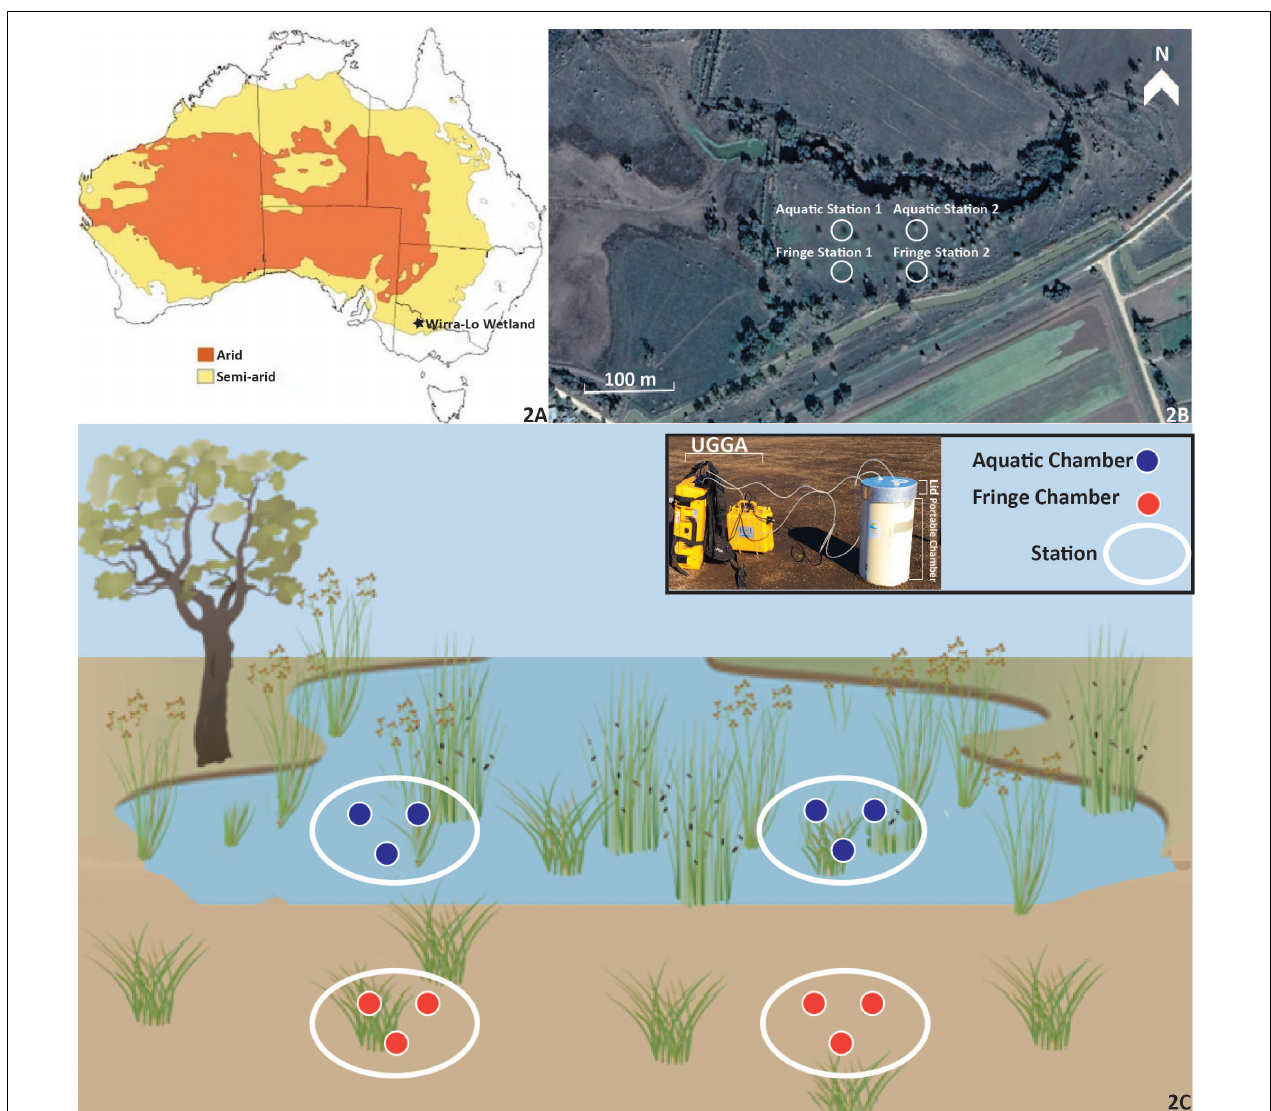
FIGURE 2 | The Wirra-lo wetland complex located in the semi-arid climate of North Central Victoria, Australia ( − 35.503353, 143.873565). Arid and semi-arid regions of Australia (A) are low in annual precipitation (100–500 mm year − 1 ) and experience high evaporation. Duck Creek North (B) , a semi-arid floodplain wetland, was measured for carbon emissions within this complex for an entire watering event. The Fringe Zone (samples taken in this zone are shown as orange circles on the edge of the wetland) and Aquatic Zone (samples taken in this zone are shown as blue circles in the inundated portion of the wetland) were identified using wetland delineation techniques (elevation and vegetation type; C ). Two stations were placed within each zone for further carbon dynamic measurements. Within each of the stations that were nested within each zone, three portable closed-chambers (C) were used to measure carbon emissions at Pre, During, Post, and 1 Month phases of environmental watering. The design of each chamber, lid and UGGA used for carbon emission measurements can be seen in the legend of C . The water used for the environmental watering event was released from the surrounding irrigation channel. The location of the three chambers within each station can be seen in B and C . Aquatic Station 1 and 2 and their corresponding chambers were filled with water during the experiment, whereas station and chambers within Fringe Station 1 and 2 remained